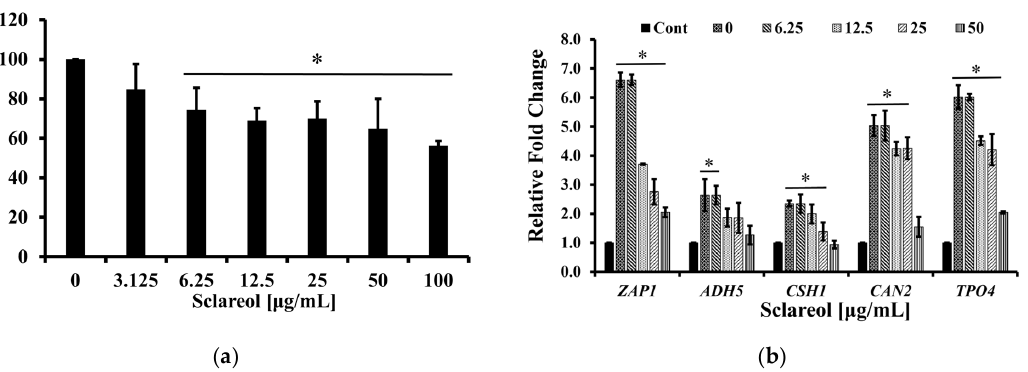
Figure 4. Sclareol inhibited the biofilm formation of C. albicans . ( a ) C. albicans biofilm was formed in medium with or without sclareol (3.125–50 μg/mL) at 37 °C for 24 h. Data are presented as the mean ± SD of triplicate experiments. * p < 0.05 was considered significant. ( b ) Sclareol inhibited the expression of genes related with biofilm formation in C. albicans . mRNA of C. albicans (KCTC7965) was obtained after 24 h treatment in biofilm formation condition. Data are presented as mean ± SD from three independent experiments. * p < 0.05. The inhibition of hyphal formation of C. albicans by sclareol was evaluated because biofilm formation is related with the morphological transition of C. albicans . Sclareol dose- dependently inhibited the hyphal formation of C. albicans (Figure 5a,c). Hyphal formation of C. albicans in spider medium is also inhibited by treatment of 50 μg/mL of sclareol (Fig- ure 5b).